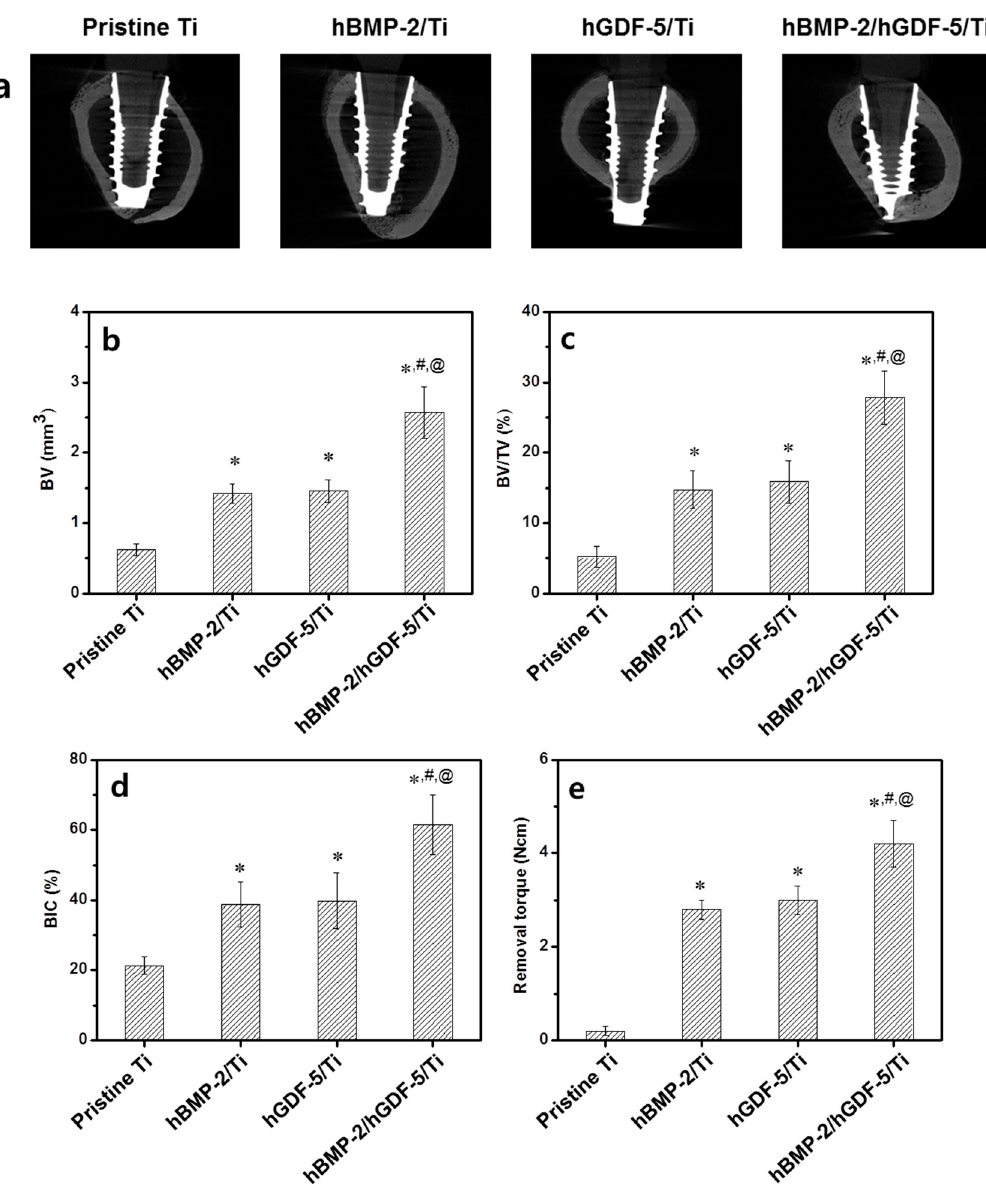
Figure 8. ( a ) Micro-CT images (white area: titanium screw and grey area: cortical bone); ( b ) amounts of BV; ( c ) percentages of BV/TV; ( d ) percentages of BIC; and ( e ) values of removal torque on pristine Ti, hBMP-2/Ti, hGDF-5/Ti, and hBMP-2/hGDF-5/Ti samples after four weeks of implantation. The error bars represent mean ± SD ( n = 3). These experiments were repeated three times (* p < 0.05, # p < 0.05, and @ p < 0.05). Controls of the p values were pristine Ti, hBMP-2/Ti, and hGDF-5/Ti, respectively.